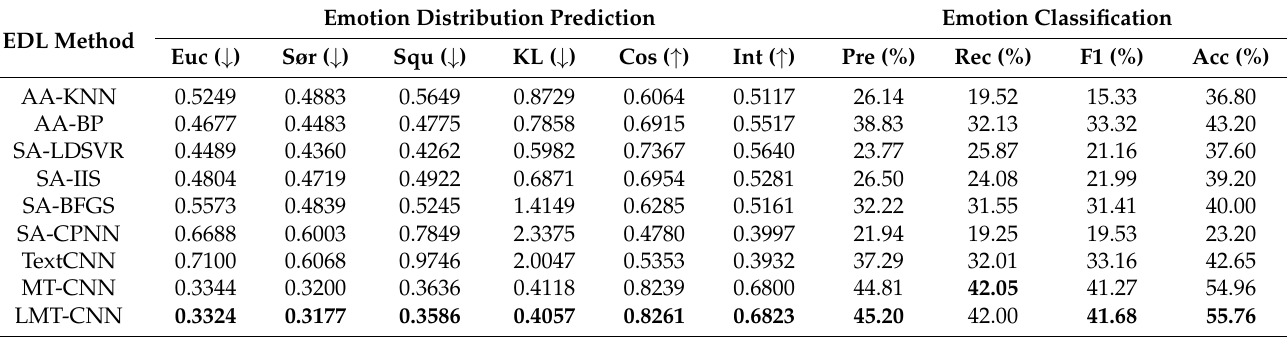
Table 4. Experimental results comparing the performance of 9 emotion distribution learning methods for emotion distribution prediction and emotion classification on the SemEval dataset ( ↑ indicates that the larger the indicator is, the better; ↓ indicates that the smaller the indicator is, the better.). The best performances of each indicator are marked in